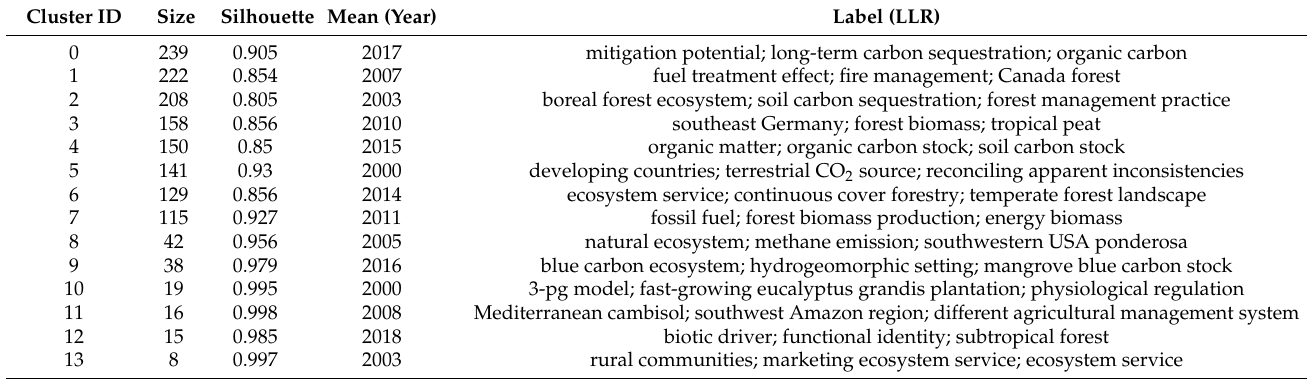
Table 9. The 10 most frequent papers in the literature co-citation